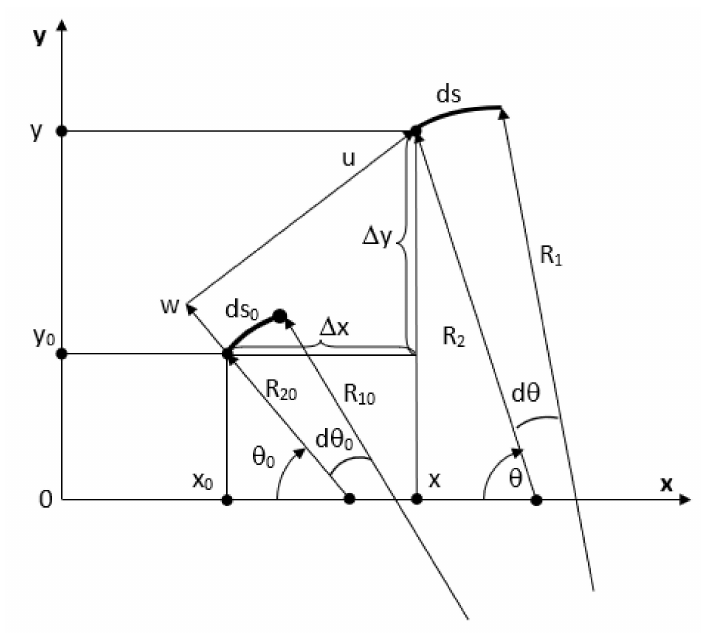
Figure 1. Element of an unstrained formative shell before the